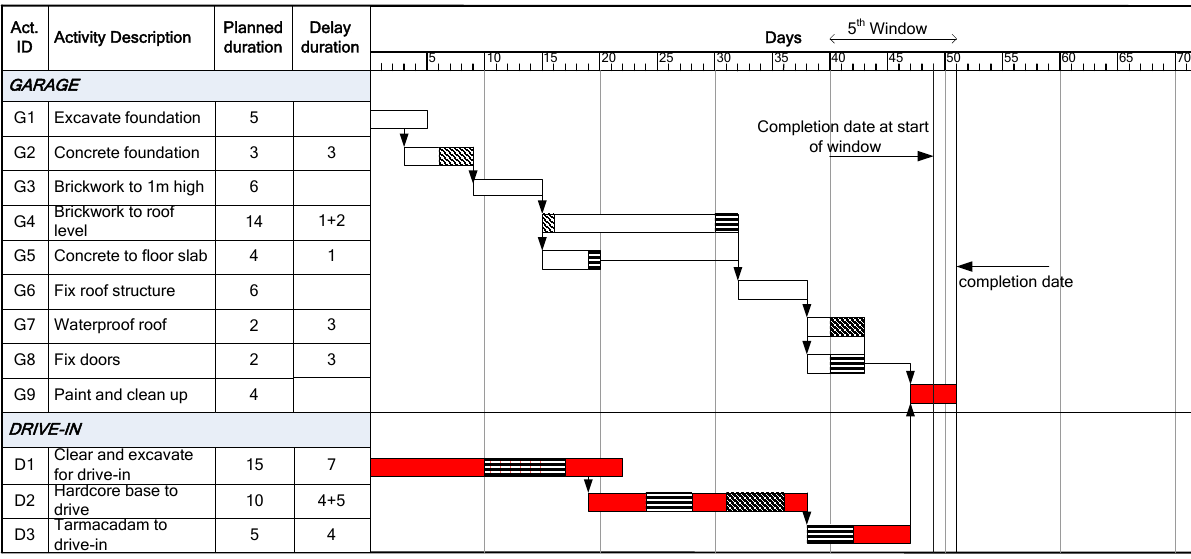
Figure 22. Updated schedule on day